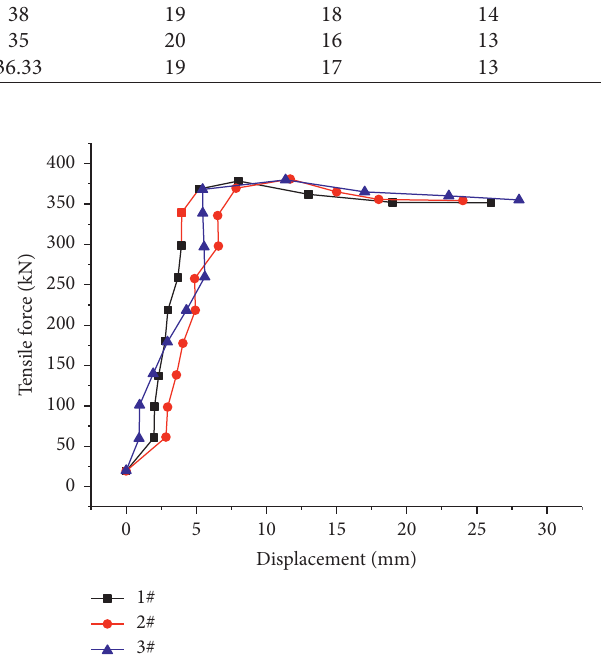
Figure 17: Relation diagram of anchor cable tension and displacement. Table 3: Basic parameters and experimental data of soil